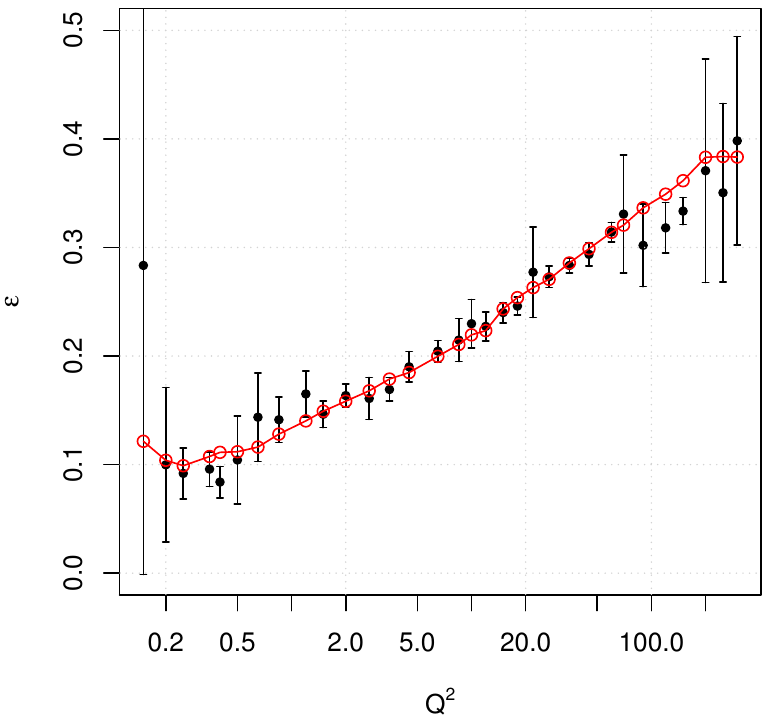
Figure 2 . The e(cid:11)ective exponent (cid:15) ( Q 2 ) in DIS. Black dots are obtained by extrapolating the log of the cross section at (cid:12)xed Q 2 with a straight line in log x . The corresponding error bars are at 3 (cid:27) . The red curve is our prediction for the e(cid:11)ective exponent using the model proposed in this work. experiment, restricted to the region of low x where Regge kinematics holds. In (cid:12)gure 2 we see the observed behaviour of the exponent (cid:15) ( Q 2